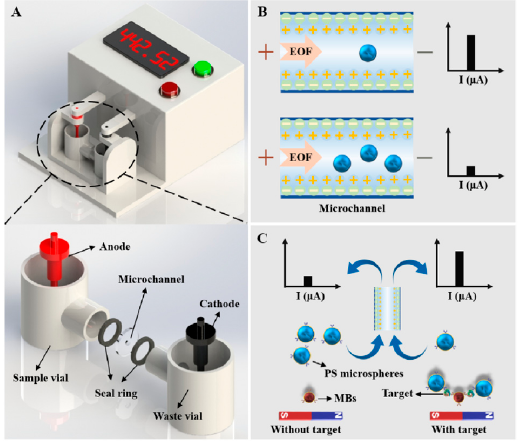
Figure 7. Biosensing principle based on the measurements of the microchannel resistance. ( A ) Biosensing device. ( B ) Dependence of the current signals on the number of the particles in the channel. ( C ) Variation of the current signals with particle size. Reproduced from Ref. [85] with permission. Copyright 2021 American Chemical Society.